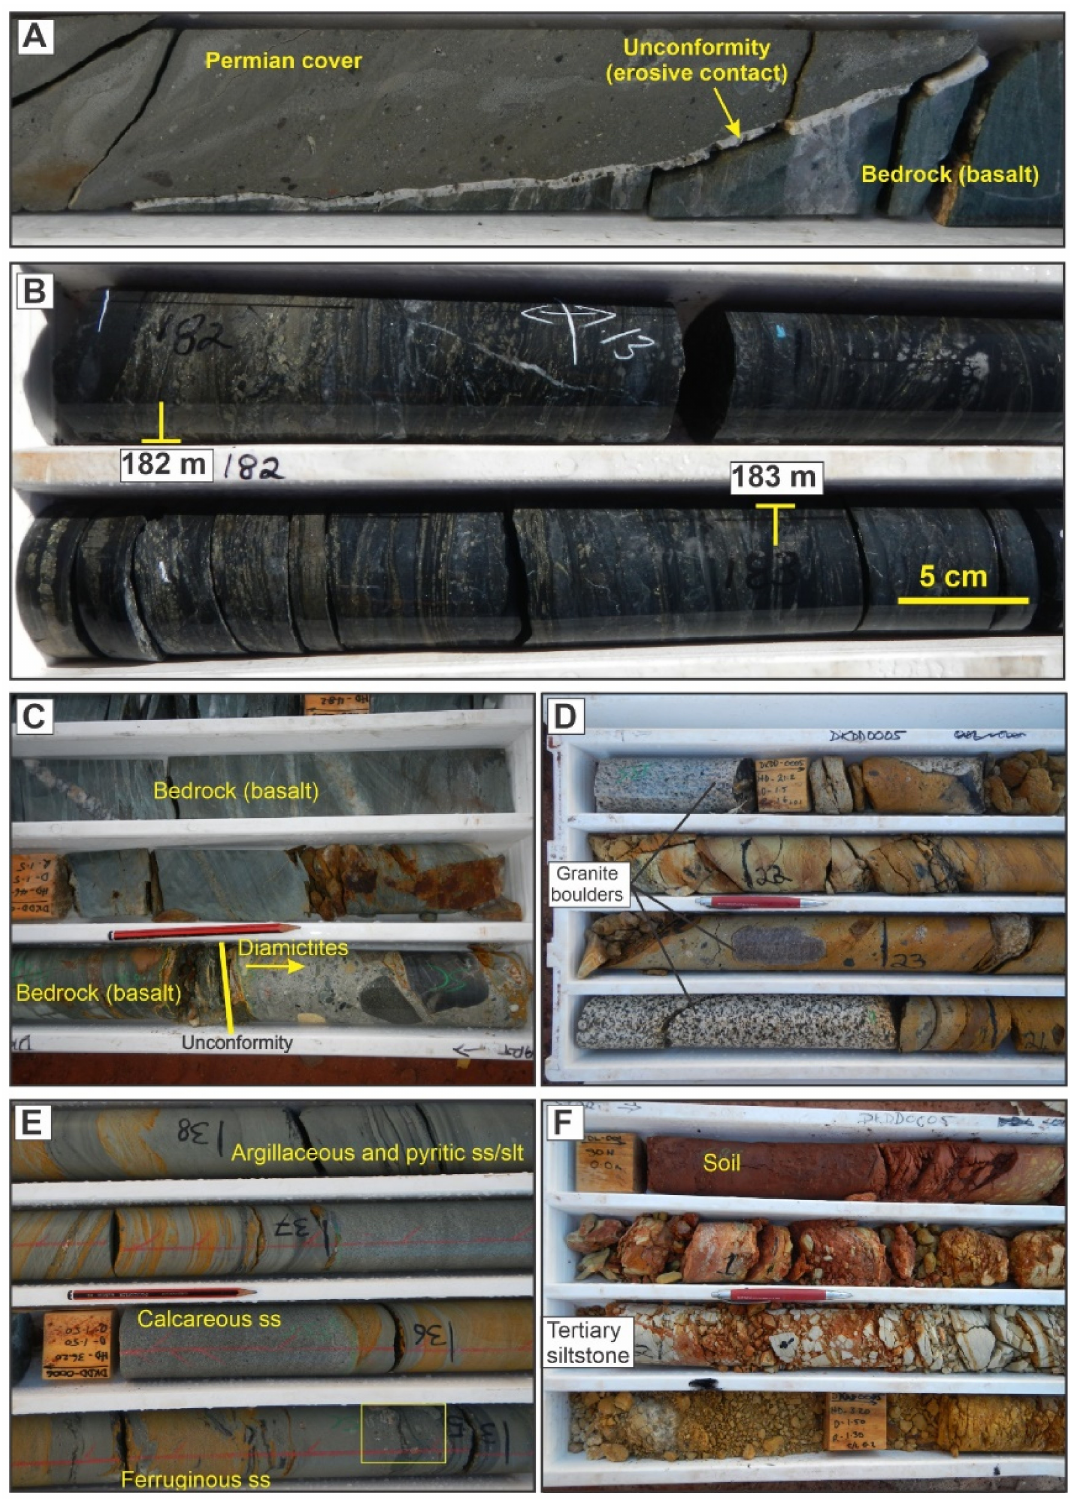
Figure 4. Diamond drill core samples from drill holes DKDD0006 and DKDD0005. ( A ) The unconformity (erosive contact) between the unweathered Permian glacial cover and the underlying basement (Archean basalt) in drill hole DKDD0006. ( B ) Sulfides in gold-mineralized sheared basalt in drill hole DKDD0006. ( C ) The unconformity between the unweathered Permian glacial cover and the underlying basement in drill hole DKDD00065. ( D ) Weathered Permian diamictites with fresh polymictic boulders. ( E ) Rhythmites consist of fresh and oxidized sandstone and siltstone layers. The yellow box shows the presence of dropstones. ( F ) Weathered Tertiary siltstone and Quaternary ferruginous